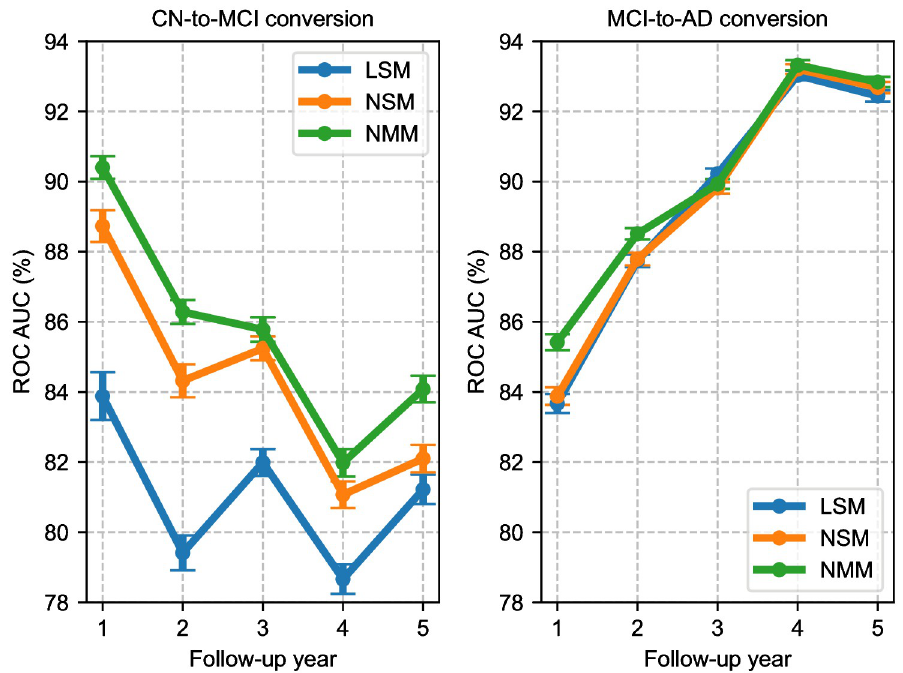
Fig 3. Predictive performance of different models for different follow-up years. ROC AUC values are averaged across 200 80–20 data splits. Error bars indicate the standard error across these splits. LSM, Linear Single-year Model; NSM, Nonlinear Single-year Model; NMM, Nonlinear Multi-year